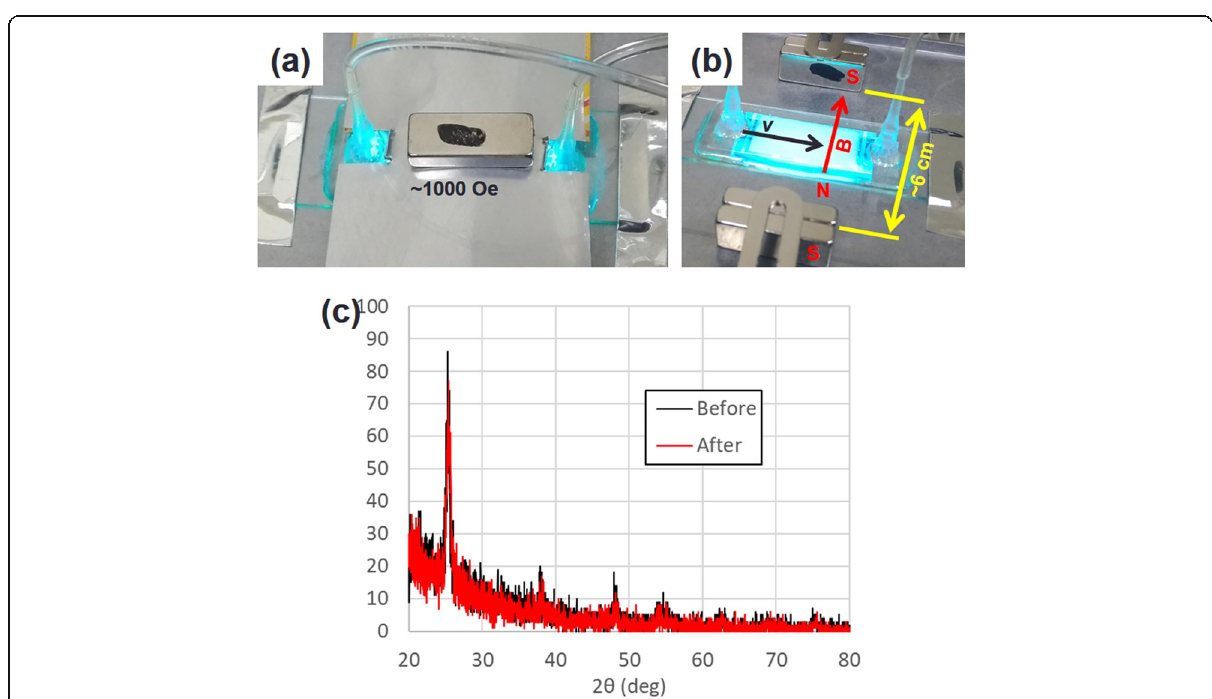
Fig. 2 Experimental setup and effects of applying a magnetic field to enhance a photocatalytic reaction. Various arrangements of the neodymium magnets to provide a a normal magnetic (NM) field and b a lateral magnetic (LM) field. c X-ray diffraction pattern before and after